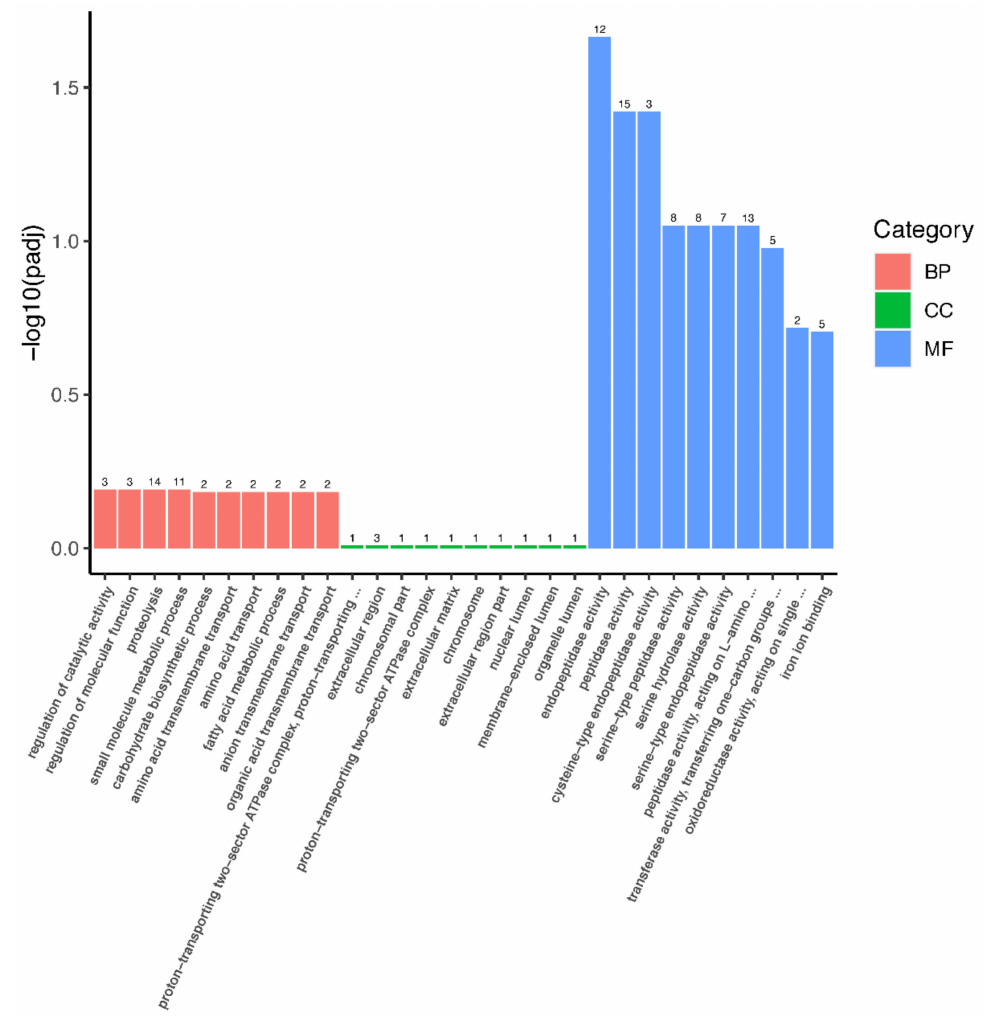
Figure 5. GO enrichment analysis of DEGs in viruliferous and non-viruliferous SBPH heads. X- axis represents GO terms; Y-axis represents the significance level of GO term enrichment. The higher the value, the more significant it is. BP: biological process; CC: cellular component; MF: molecular